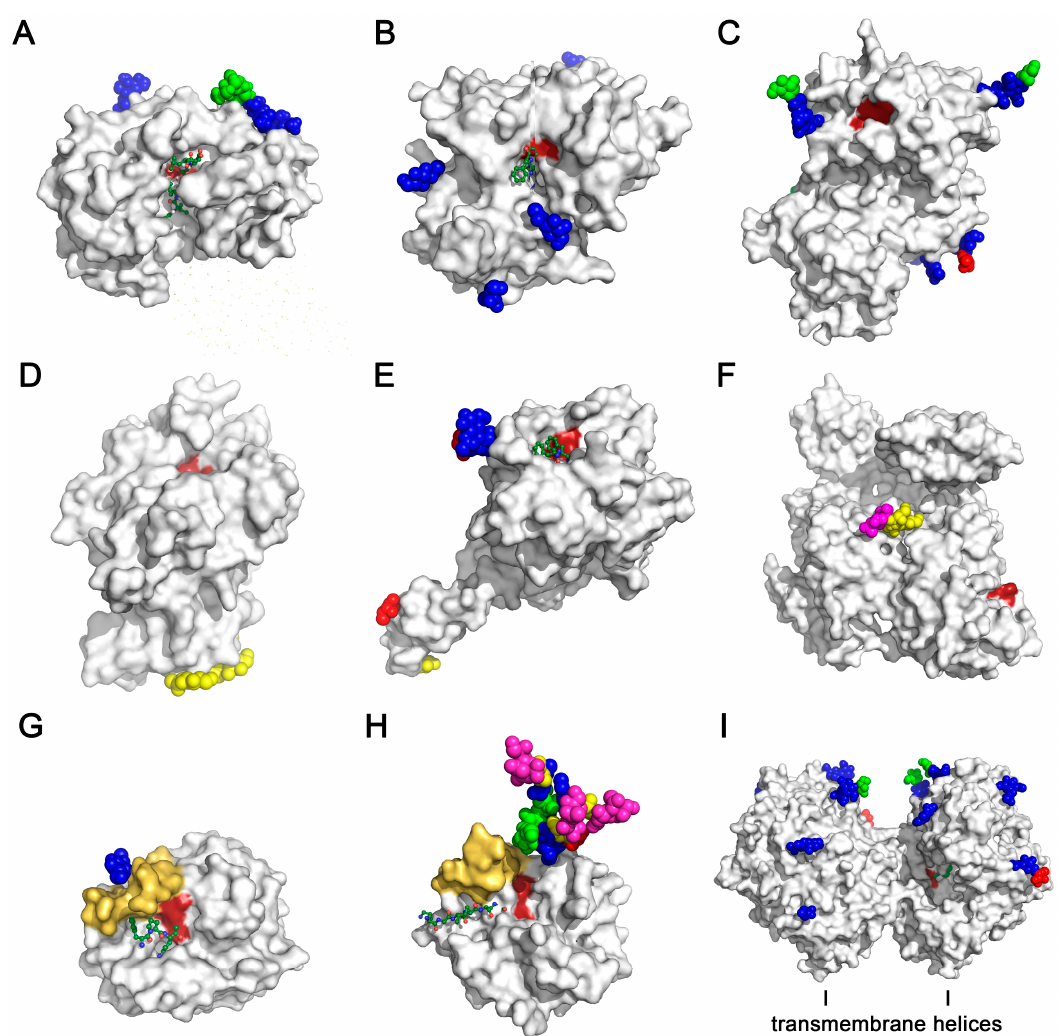
Figure 3. Selected human proteases shown as molecular surface with glycans as spheres according to the standard sugar coloring scheme (Figure 1). Active site residues are colored dark red, while inhibitors or substrates are shown as ball-and-stick models. ( A ) The aspartic protease cathepsin D with two N -glycans distant from the active sit cleft (1LYA/1LYB); ( B ) The papain-like cysteine protease cathepsin C has four N -glycans, one is located near the substrate binding region (1K3B/2DJF); ( C ) The metalloprotease meprin β carries seven N -glycans, with the one at Asn254 located at the substrate binding cleft near the catalytic Zn 2+ (4GWM); ( D ) Carboxypeptidase N is another Zn 2+ -dependent protease, with three O -glycans distant to the active site (2NSM); ( E ) The trypsin-like factor VII is an important activator in the blood coagulation cascade, exhibiting an N -glycan in the catalytic domain and two O -glycans in the EGF-like domain 1 (1QFK); ( F ) Plasmin, another trypsin-like protease degrades fibrin clots and is O -glycosylated between kringle domains 3 and 4 (4DUR); ( G ) The trypsin-like KLK1 exhibits one N -linked GlcNAc of a core glycan (1SPJ), which is sufficient to rigidify the flexible 99-loop (yellow) at the active sit cleft, filled with the PPACK inhibitor of the closely related KLK2 (4NFF), in order to explain the effect of glycosylation on substrate binding. In glycan-free KLK2, the 99-loop is more flexible and open; ( H ) The chymotrypsin-like KLK3/PSA carries a triantennary N -glycan, which may enhance binding of natural substrates and inhibitors (3QUM/2ZCK). The flexible 99-loop resembles the one of KLK1 (Figure 3G) and is depicted in yellow; ( I ) DPP4 is a membrane anchored, dimeric α / β -hydrolase, with the shielded active site located inside a cavity. The glycans may prevent aggregation and could play a role in the receptor function of DPP4 (1N1M).